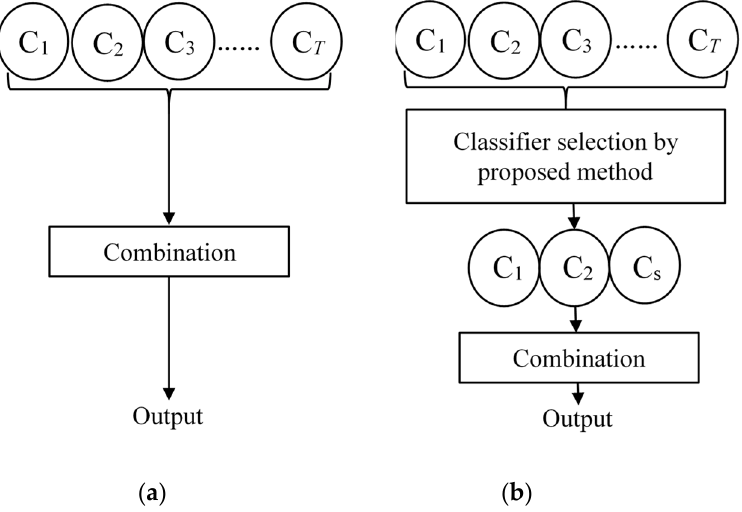
Figure 6. Comparison of the combination method with classifier selection or not: ( a ) direct combination method and ( b ) selection-based combination method.